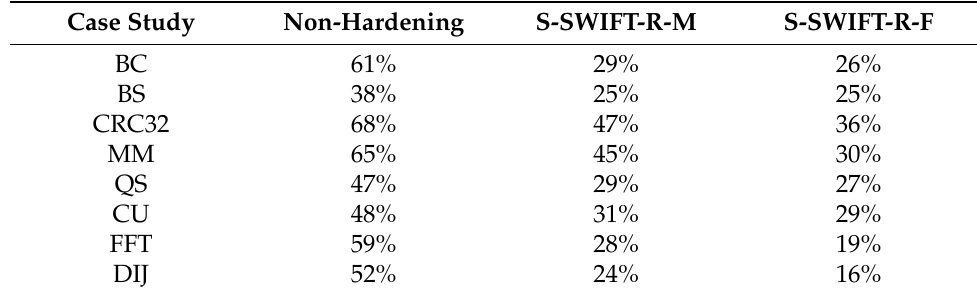
Table 4. The SDC amount in CFE fault